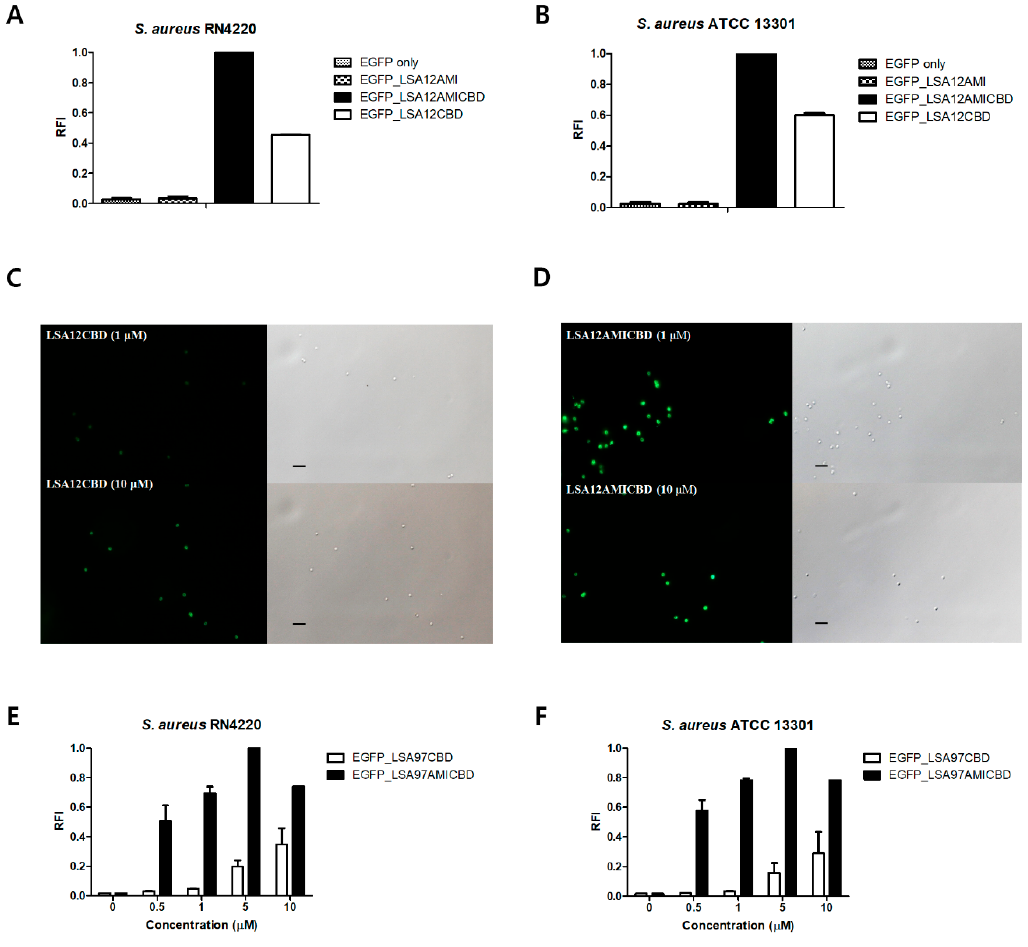
Figure 4. Binding activity comparison among EGFP-fused LysSA12 derivatives. Relative cell binding activities of 1 μ M of EGFP_LSA12AMI, EGFP_LSA12AMICBD, and EGFP_LSA12CBD toward ( A ) S. aureus RN4220 and ( B ) S. aureus ATCC 13301. Optical and florescent images of S. aureus RN4220 after the addition of ( C ) EGFP_LSA12CBD and ( D ) EGFP_LSA12AMICBD at 1 μ M (top) and 10 μ M (bottom). Relative cell binding activities of EGFP_LSA12CBD and EGFP_LSA12AMICBD were measured with ( E ) S. aureus RN4220 and ( F ) S. aureus ATCC 13301 at different concentrations. EGFP did not show binding to S. aureus. The data shown are the mean values from three independent measurements and the error bars represent the standard deviations. The scale bar represents 2 μ m.